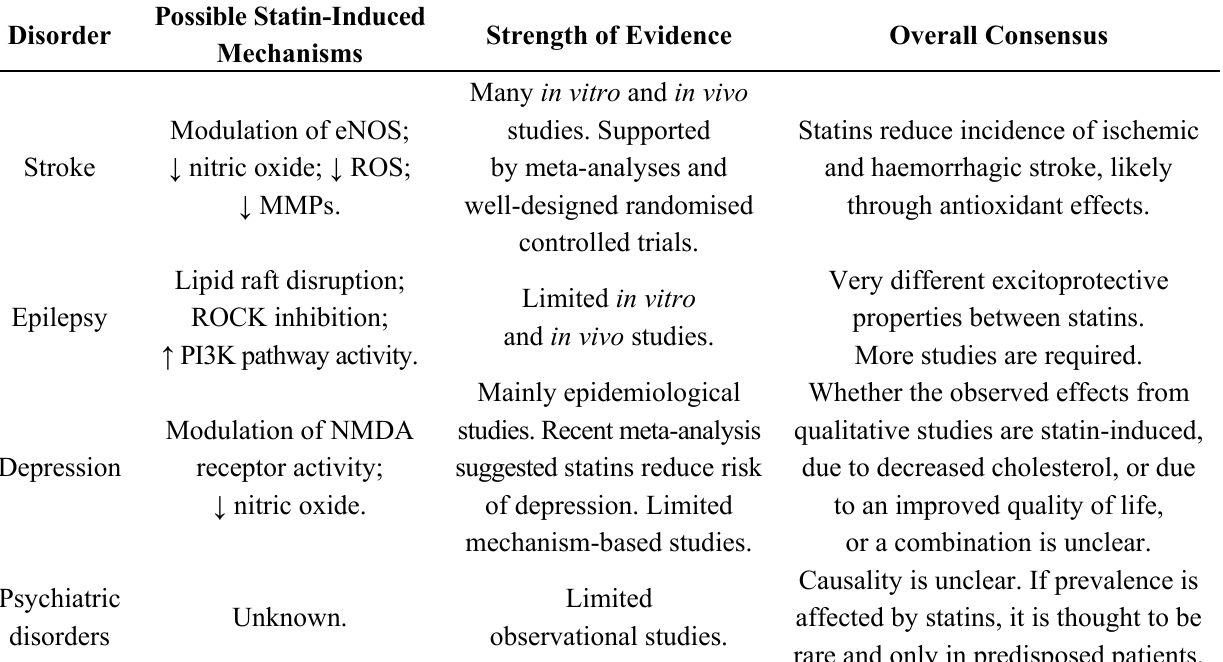
Table 3. Summary of statins’ effects on neurological